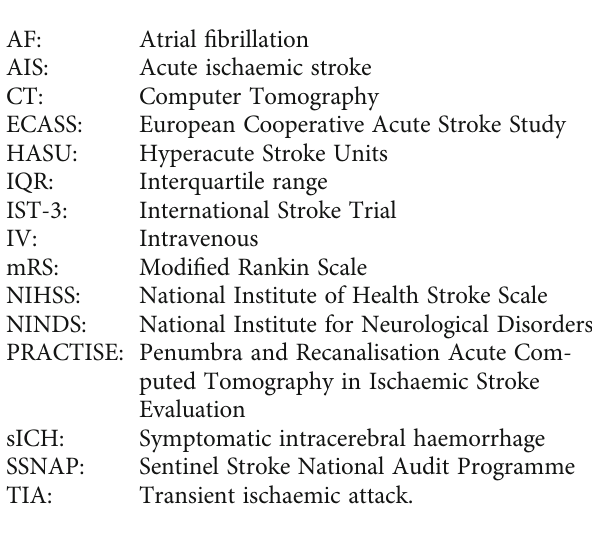
Supplementary Figure 1: the comparison of proportions of patients in all stroke severity in two age groups. The dis- tribution of discharge modi fi ed Rankin Scale, using Fried- man ’ s two-way ANOVA test, p < 0 : 001 . In the latter two years, thrombectomy numbers picked up, and this proba- bly biased the outcome. (Supplementary